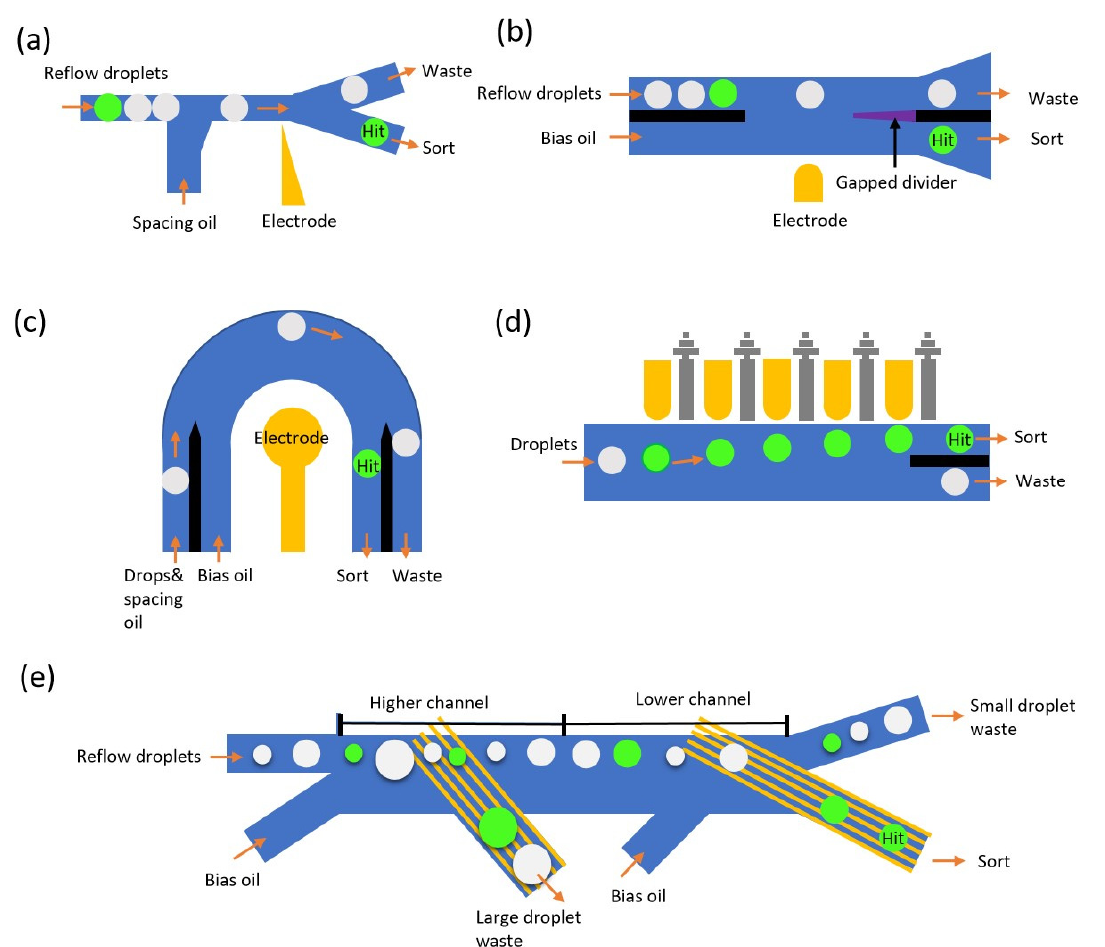
Figure 5. Variety of different types of DEP droplet sorters. ( a ) A typical first-generation DEP droplet sorter; droplets with color dye are sorted by DEP force into the bottom channel. ( b ) A schematic of the fast droplet sorter, with detected and selectively displaced green droplets being separated by a gapped divider (purple) of reduced channel height. ( c ) Schematic of the concentric design with inlet and outlet channels labeled. Black areas represent oil bypass regions generated by double-layer fabrication. ( d ) Schematic of the SADA-based fluorescence-activated droplet sorter (SADA sorter in short). ( e ) The working principle and design of the size-based droplet manipulation scheme using IDE-generated DEP force and the droplet buoyancy phenomena. This top view of the droplet manipulation region illustrates that larger droplets will follow the trajectory of the surface IDE patterns, while the smaller droplets will continue to flow to the waste outlet uninterrupted by the IDE-generated DEP